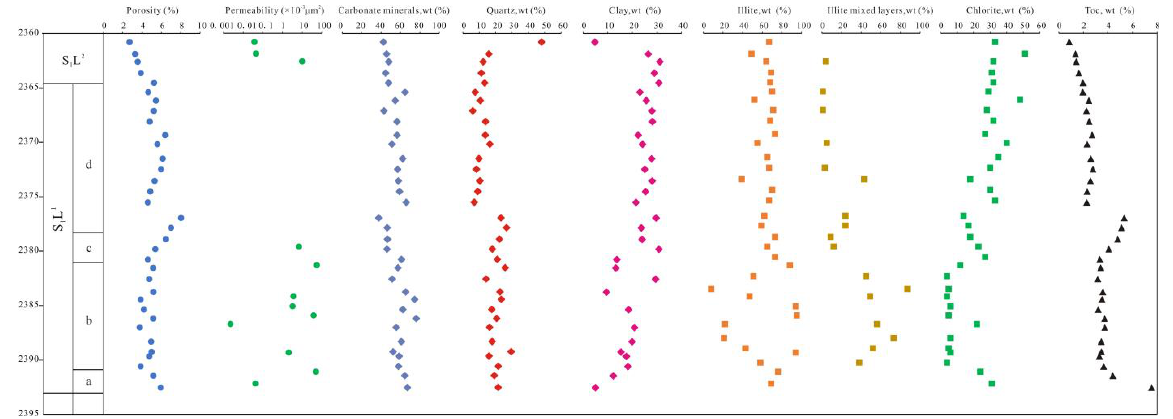
Figure 9. Comparison of profile distribution of physical properties and mineral components of S 1 l 1 −1 section. S 1 l 1 −1 a~c section is the organic-rich siliceous mud shed microfacies of a deep-water shelf facies in a reduction environment, and the S 1 l 1 −1 ~d layer is the organic rich clay mud shed microfacies in the deepwater shelf. The content of siliceous mineral components in a re- duction environment is high at generally more than 30%, the proportion of siliceous min- erals in the S 1 l 1 −1 a and S 1 l 1 −1 b sections is higher than 45%, and there is a big difference within the S 1 l 1 −1 c section since at the bottom of the formation the proportion is 37% while the pro- portion decrease to 30.46% at the top. Due to the oxidation environment of the S 1 l 1 −1 d sec- tion, the siliceous content is less than 22%. In general, with the water depth moving from deep to shallow, the sedimentary environment changes from reduction to oxidation, and the silicon content decreases from bottom to top. The content of clay minerals in the S 1 l 1 −1 a , S 1 l 1 −1 b and lower part of S 1 l 1 −1 c is less than 20%, while that in the upper part of S 1 l 1 −1 c is 35.95%, and that in S 1 l 1 −1 d is more than 50%. In addition, the content of carbonate minerals also decreases from bottom to top, with the highest content of 25.19% at the top of S 1 l 1 −1 a and the lowest content of 4.5% at the top of S1l1-1d (Figure 10, Table 2).